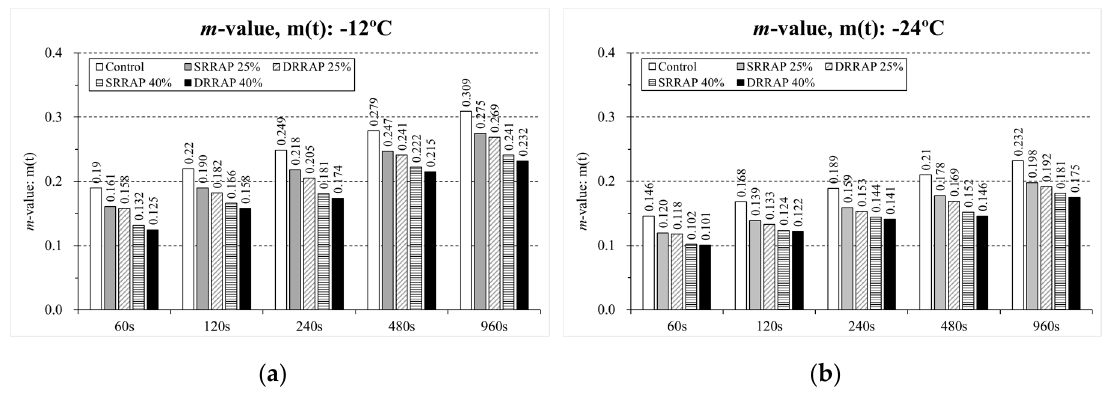
Figure 6. m -value, m ( t ), at different testing time. ( a ) T = − 12 °C; ( b ) T = − 24 °C.